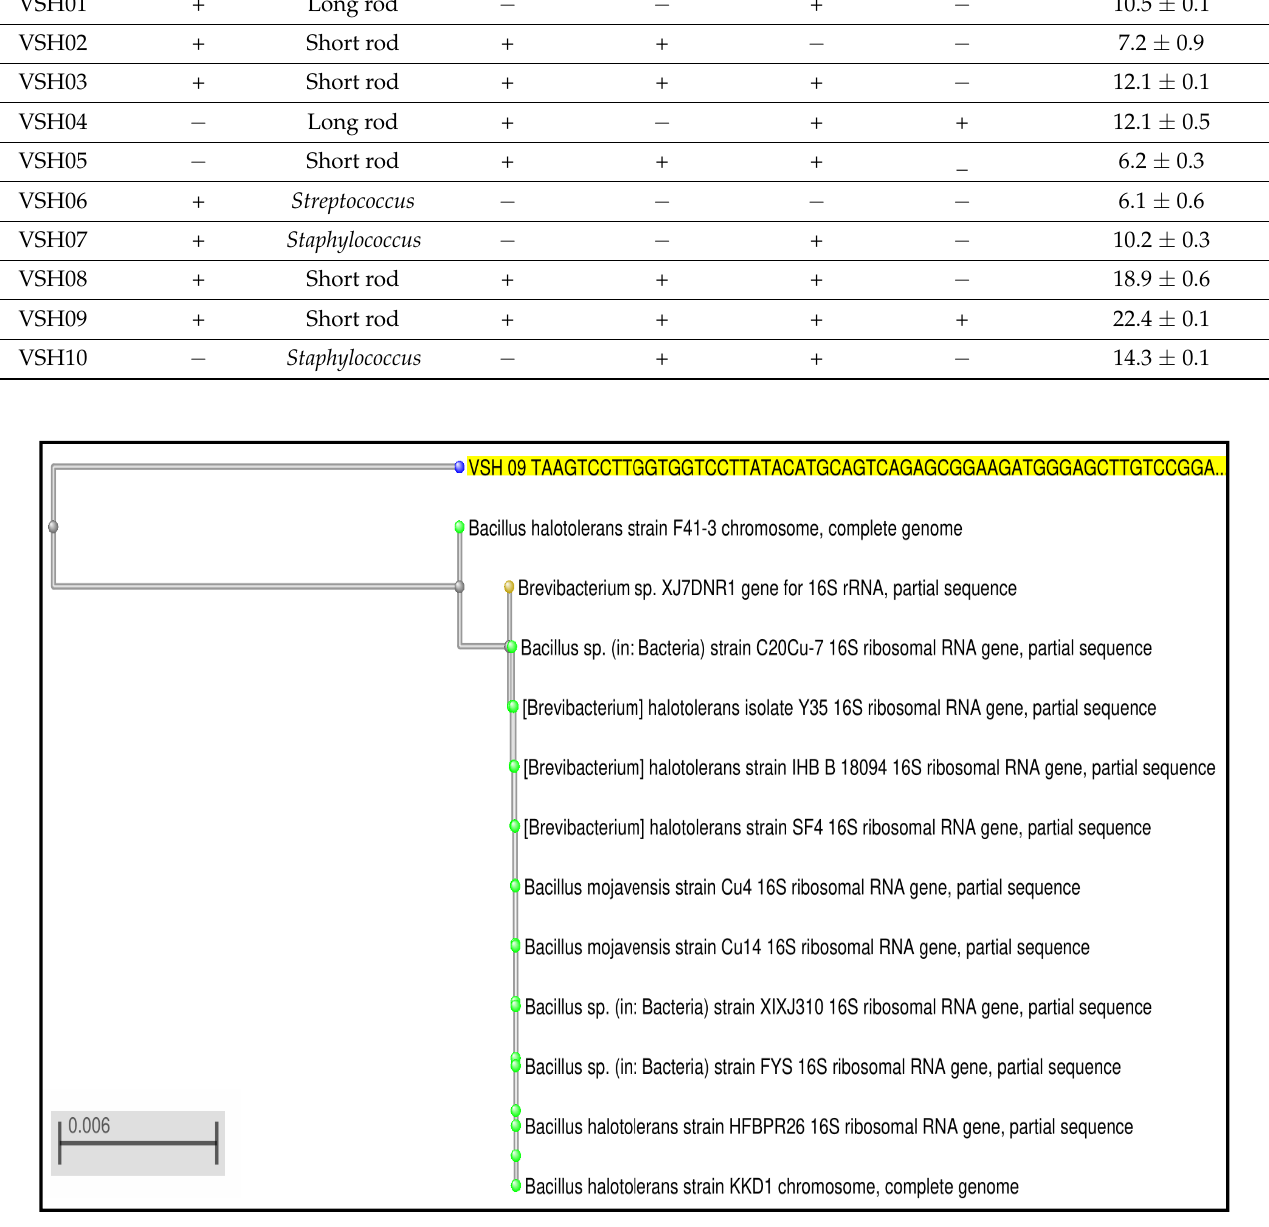
Figure 3. Phylogenetic analysis of 16S rDNA gene for VSH 09.